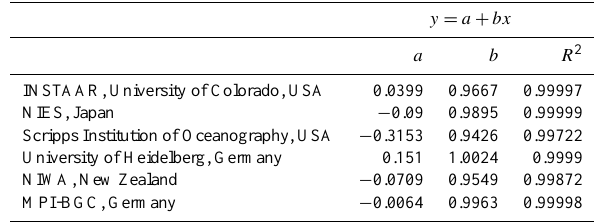
Fig. 2. Regression and residuals plots of MPI-BGC measurements Figure 2. Regression and residuals plots of MPI-BGC measurements (n=15) of JRAS gases treated as Figure 2. Regression and residuals plots of MPI-BGC measurements (n=15) of JRAS gases treated as ( n = 15) of JRAS gases treated as independent samples to the orig- independent samples to the originally assigned values on the JRAS-06 scale. Left panels show the  13 C independent samples to the originally assigned values on the JRAS-06 scale. Left panels show the  13 C inally assigned values on the JRAS-06 scale. Left panels show the data and right panels the corresponding  18 O data. data and right panels the corresponding  18 O data. δ 13 C data and right panels the corresponding δ 18 O data. Figure 2. Regression and residuals plots of MPI-BGC measurements (n=15) of JRAS gases treated as Figure 2. Regression and residuals plots of MPI-BGC measurements (n=15) of JRAS gases treated as independent samples to the originally assigned values on the JRAS-06 scale. Left panels show the  13 C independent samples to the originally assigned values on the JRAS-06 scale. Left panels show the  13 C data and right panels the corresponding  18 O data. Table 3. δ 18 O results. Linear regression resulting from comparing 7 data and right panels the corresponding  18 O data. 7 local scales to